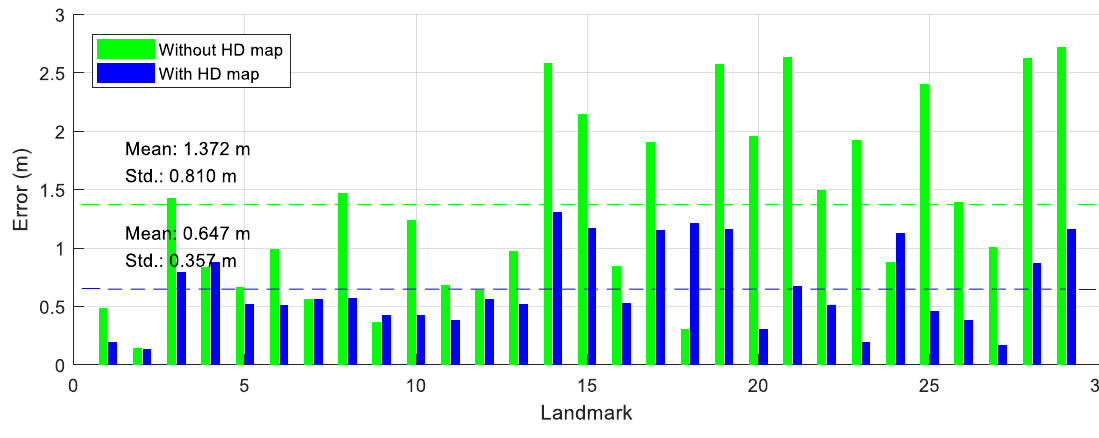
Figure 6. The errors of the new features.